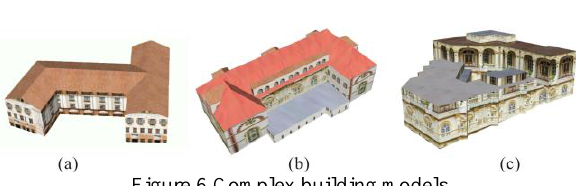
Figure 5. Construction of simple buildings